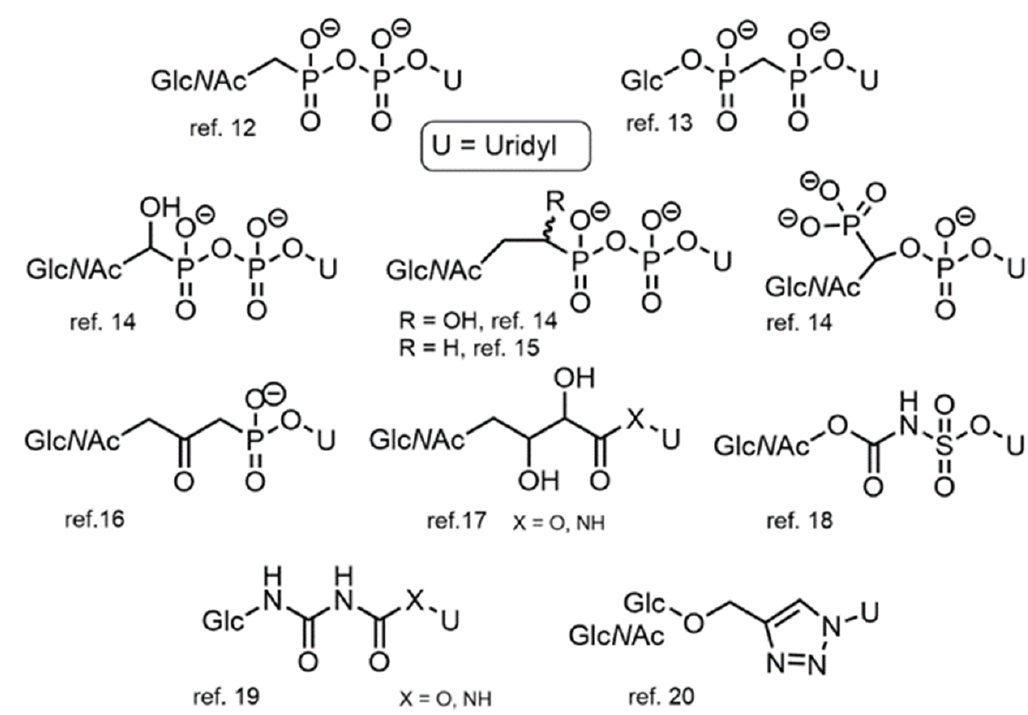
Figure 2. Examples of synthetic analogs of UDP-Glc or UDP-Glc N Ac .